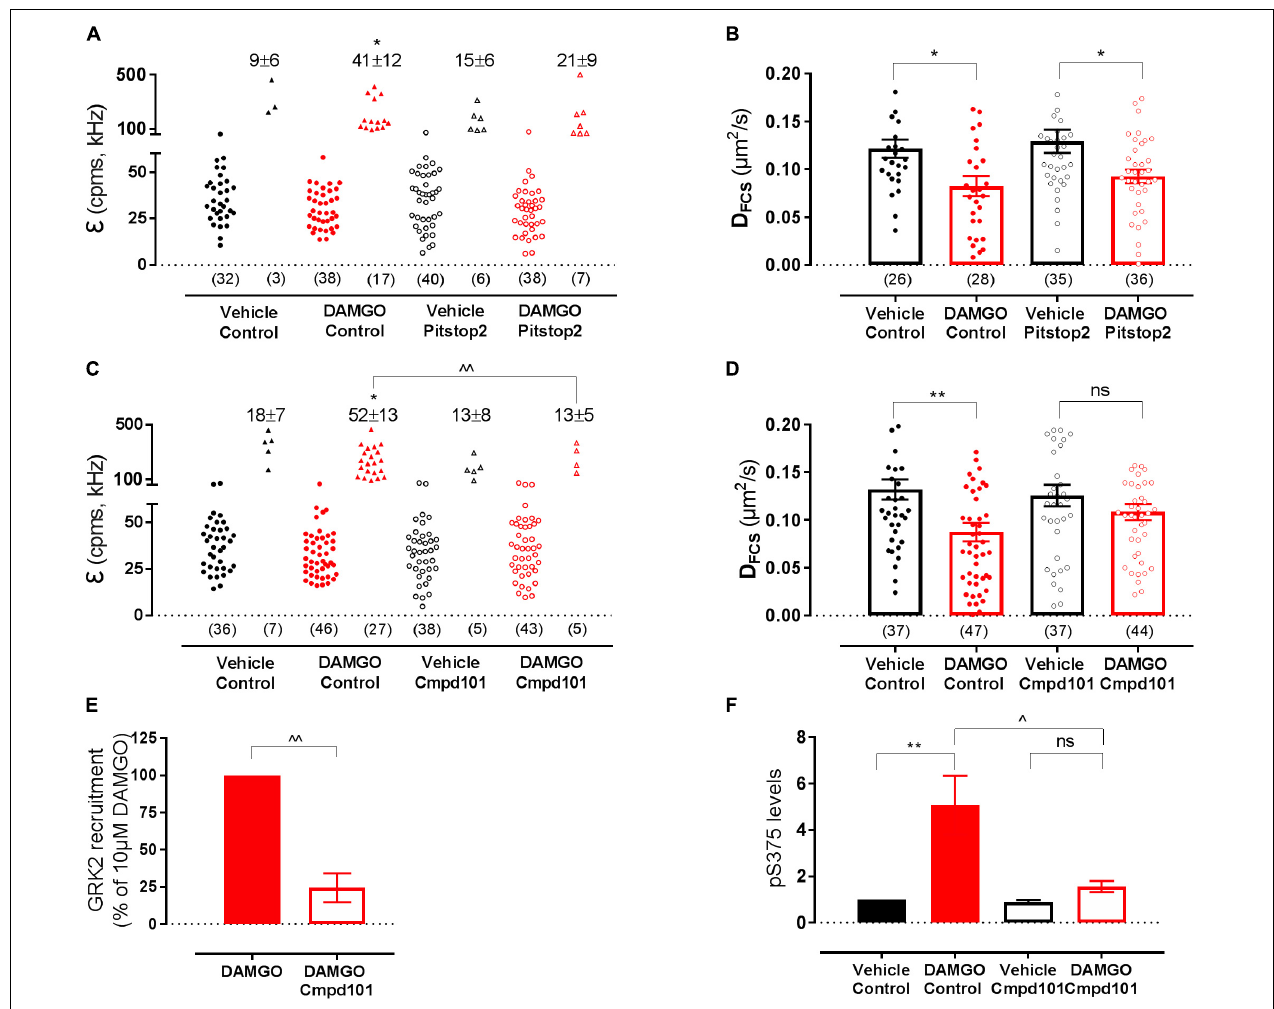
FIGURE 5 | Effect of internalization inhibitor Pitstop2 and GRK2/3 inhibitor Cmpd101 on SNAP-MOP membrane organization. HEK293 SNAP-MOP cells were exposed to the internalization inhibitor Pitstop2 (30 µ M, 30 min, 37 ◦ C) or GRK2/3 inhibitor Cmpd101 (30 µ M, 30 min, 37 ◦ C). (A) Molecular brightness of SNAP-MOP after stimulation with vehicle or 10 µ M DAMGO in control or Pitstop2 pre-treated cells [ n = 32–40 cells from 6 to 8 independent experiments, one-way ANOVA, F (df1,df2): F (3,26) 2.67, P = 0.060]. (B) Diffusion coefficient of SNAP-MOP upon stimulation with vehicle or 10 µ M DAMGO in control or Pitstop2 pre-treated cells [ n = 26–36 from 6 to 8 independent experiments, F (3,121) = 5.00, P = 0.003]. (C) Molecular brightness of SNAP-MOP after stimulation with vehicle or 10 µ M DAMGO in control or Cmpd101 pre-treated cells [ n = 36–46 cells from 6 to 8 independent experiments, F (3,28) = 4.86, P = 0.008]. (D) Diffusion coefficient of SNAP-MOP upon stimulation with vehicle or 10 µ M DAMGO in control or Cmpd101 pre-treated cells [ n = 37–47 cells from 6 to 8 independent experiments, F (3,161) = 4.15, P = 0.007]. For each condition of the molecular brightness data, brightness values for the first (left) and second (right) component are shown, with the number of cells requiring a two-component fit indicated as percentage. Each data point on the scatter plots represents a measurement from an individual cell (number of cells in parenthesis) and column plots represent mean ± SEM of the indicated number of cells or individual experiments. (E) HEK293 were transiently transfected with FLAG-MOP-NLuc and GRK2-Venus to measure GRK2 recruitment in a BRET assay after stimulation with 10 µ M DAMGO in control or Cmpd101 pre-treated cells ( n = 3 independent experiments). The BRET ratio of vehicle-treated cells was subtracted, data represent mean ± SEM normalized to control condition, ∧∧ denotes significance vs. DAMGO alone ( P = 0.002, unpaired Student’s t -test). (F) Quantification of pS375 FLAG-MOP upon stimulation with vehicle or 1 µ M DAMGO in control or Cmpd101 pre-treated cells. Phosphorylation of S375 was quantified as the ratio of anti-phosphoS375 (pS375) MOP site antibody immunostaining divided by FLAG immunostaining and normalized to vehicle of the control condition [ n = 3 independent experiments, F (3,8) = 9.348, P = 0.005]. ∗ denotes significance vs. vehicle treatment and ∧ denotes significance vs. DAMGO control in one-way ANOVA with Sidak’s multiple comparisons test (ns, not significant, P > 0.05, ∗ P < 0.05, ∗∗ P < 0.01, ∧ P < 0.05, ∧∧ P <